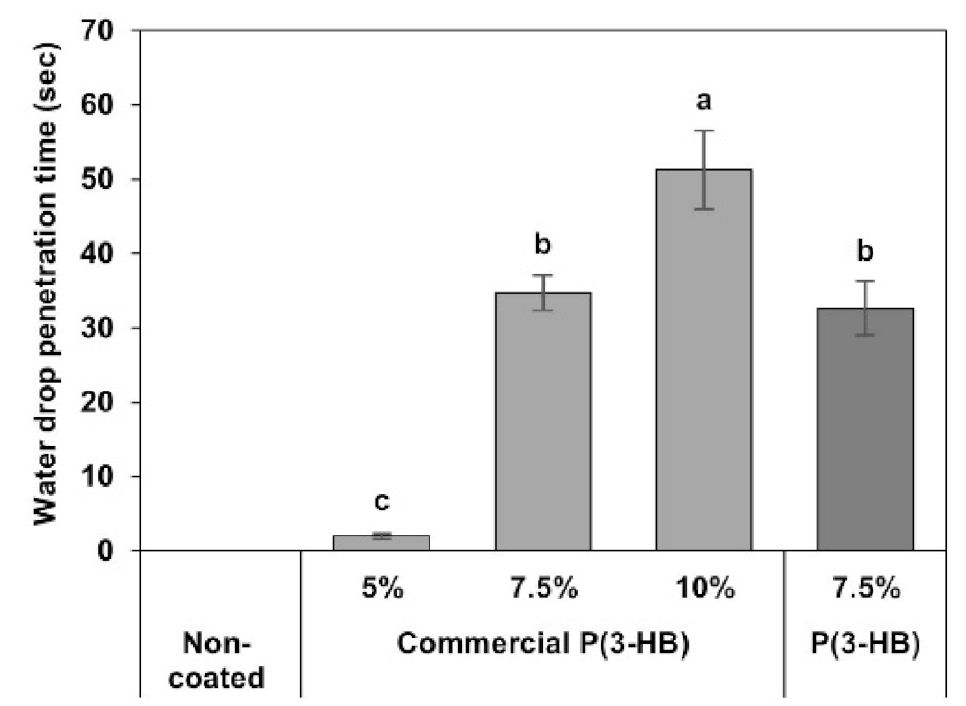
Figure 5. Water drop penetration time on surface of the non-coated PLFP, the commercial P(3-HB) coated PLFPs at 5%, 7.5% and 10% ( w/v ) and the biosynthesized P(3HB) coated PLFP at 7.5% ( w/v ). Different letters above graph bars are represent the different between the averages of each parameter at significance level of p ≤